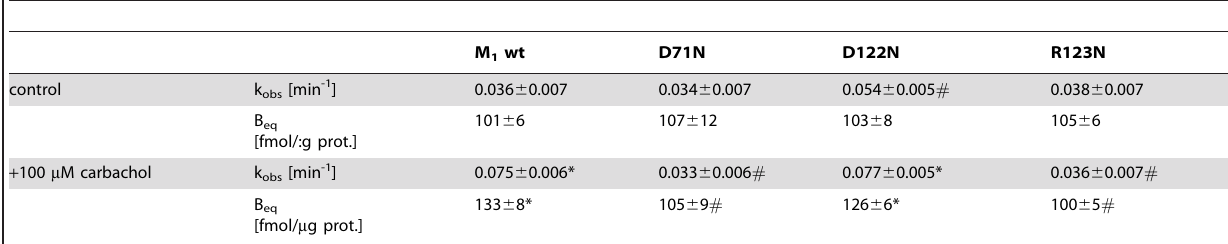
Table 5. Rates of basal and carbachol-stimulated association of [ 35 S]GTP c S in CHO membranes expressing wild type and mutant M 1 receptors.